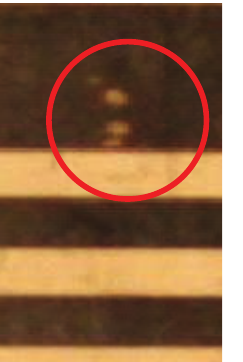
Fig. 2 . A fragment of the coded levelling meter